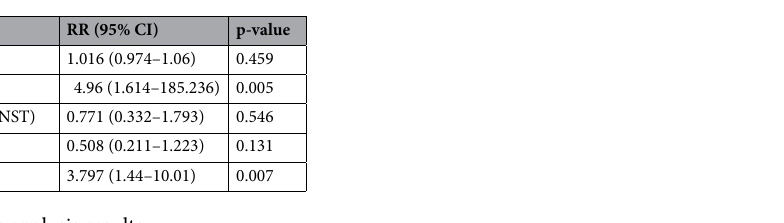
Table 2. Multivariate analysis